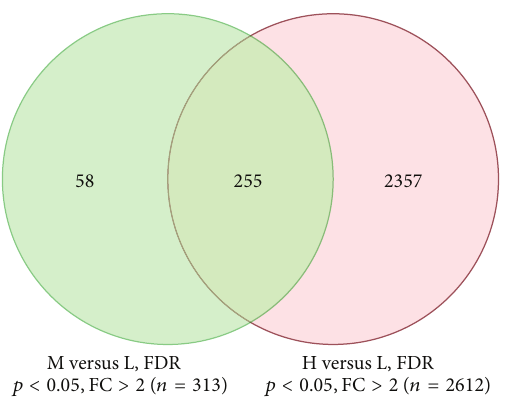
Figure 3: Number of significant genes between the two compar- isons: H versus L and M versus L. FC: fold